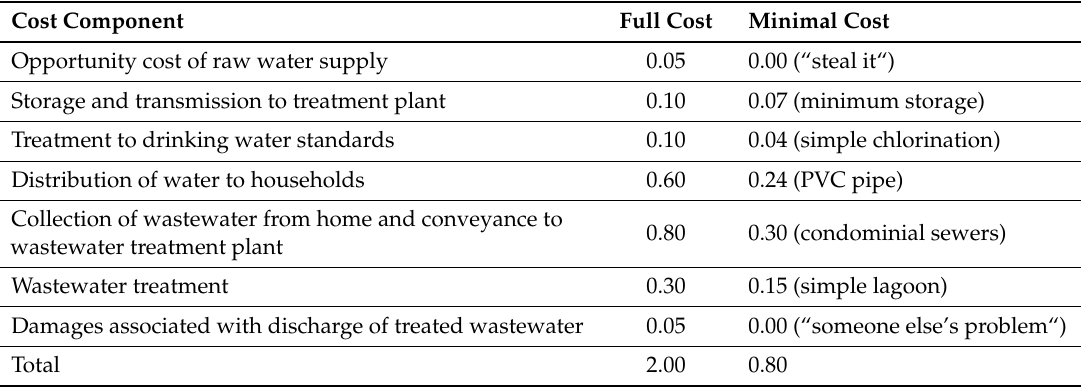
Table 5. Cost estimates of improved water and wastewater services, US$ per m 3 .